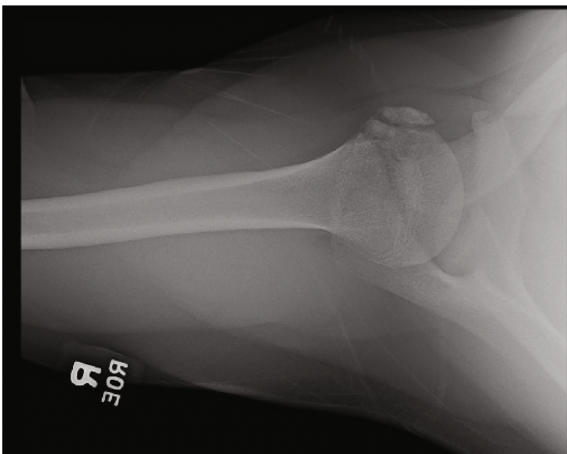
Figure 2: Axillary X-ray reveals age indeterminate fracture from the humeral head at the time of outpatient follow-up one year after injury.